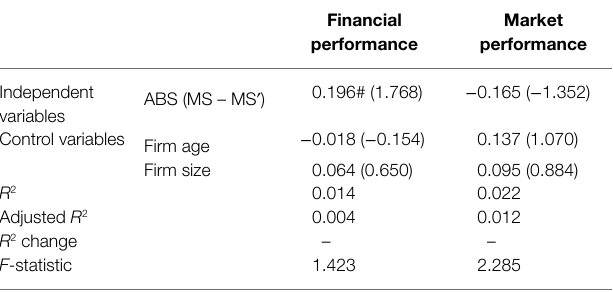
TABLE 10 | Regression analysis of servitization level residuals on enterprise performance.